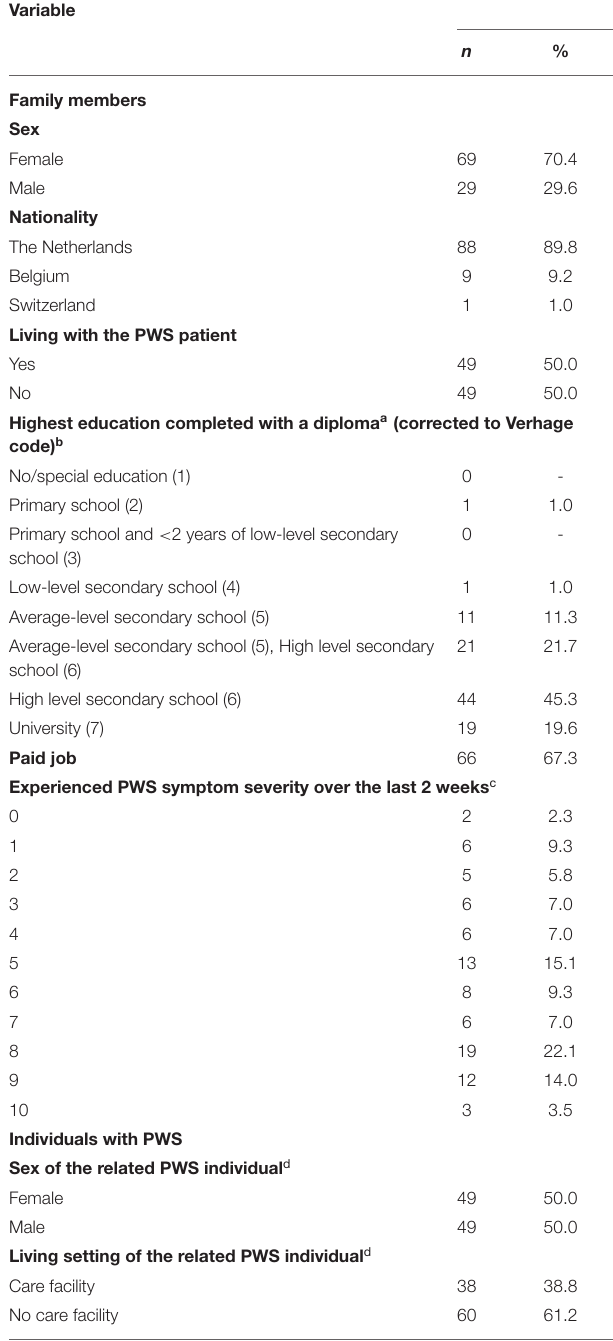
TABLE 2 | Characteristics of family members and individuals with